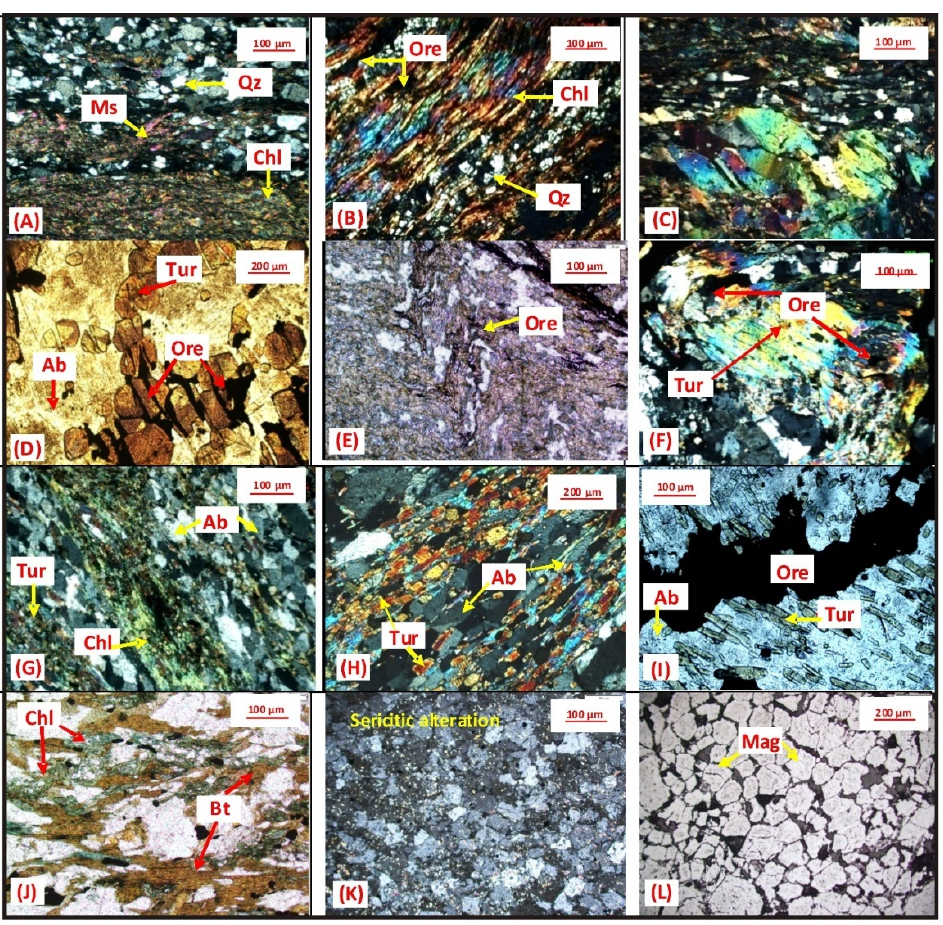
Figure 6. Photomicrograph showing mineral assemblages related to alteration zones, D 2 deformation and shear system. ( A ) Quartz-mica schist is mainly consists of muscovite, chlorite and quartz; ( B ) Alternate bandings of quartz and chlorite rich layers within quartz-mica schist; ( C ) Mica fish structure within quartz-mica schist indicating dextral nature of the shear zone; ( D ) Gold-sulfide mineralization is associated with extensive hydrothermal alterations viz. albitization and tourmalinization, also to note that mineralization is occurring parallel to the fractures of tourmaline grains; ( E , F ) F 2 fold in quartz-mica schist with disposition of opaque minerals at the hinge; ( G , H ) Elongated albite and tourmaline grains in albitite close to shear zone; ( I ) Sulfide vein cross cutting the foliation of albite-tourmaline grains in albitite; ( J ) Alteration of biotite to chlorite in proximity to sulfide disseminations; ( K ) Sericitic alteration in albitite (PPL); ( L ) Angular grains of magnetite within iron oxide breccia. (Mag = magnetite, Ms = muscovite, Qz = quartz, Chl = chlorite, Ab = albite, Tur = tourmaline, PPL = plane polarized light).